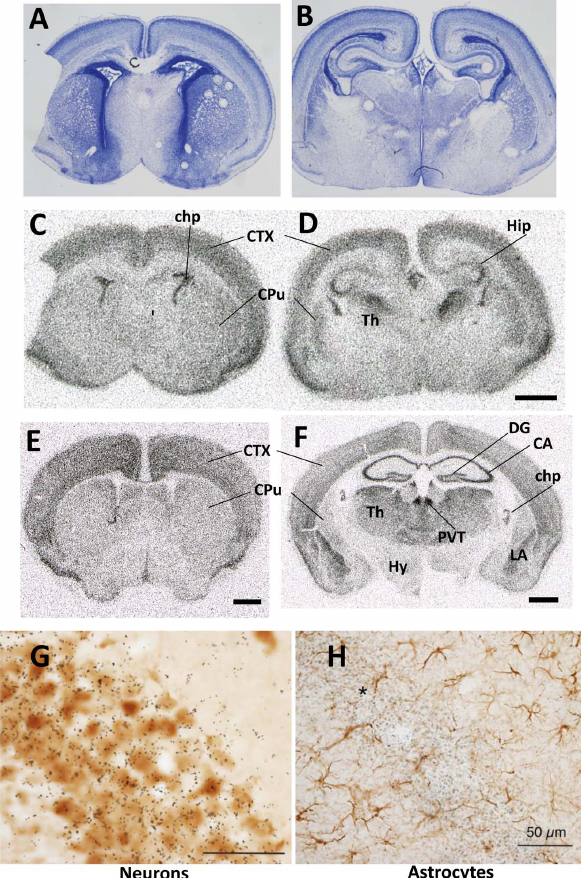
Figure 1. Lat2 expression. A–D: P0: A and B are Nissl staining and C and D in situ hybridization radioautographs. E and F: P21 in situ hybridization radioautographs. Abbreviations: chp, choroid plexus; CTX, cerebral neocortex; CA, cornus Ammonis; CPu, caudate-putamen; DG, dentate gyrus; Hy, hypothalamus, Hip, hippocampus; Th, thalamus; PVT, thalamic paraventricular nucleus; LA, lateral amygdala. G: in situ hybridization (P21) with 35 S-Lat2 probe combined with immunohisto- chemistry for NeuN to reveal neurons. Hippocampal CA1 field. H: Similar field as G, but at lower magnification, with cells stained for glial fibrillary acidic protein (GFAP). The majority of the silver grains can be seen on the neuronal pyramidal layer (asterisk) with background signal on the astrocytes. Scale bars were 1 mm in C–D, E and F, and 50 m m in G and H.